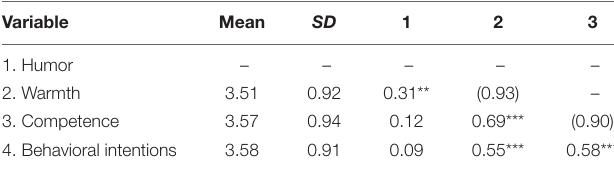
TABLE 1 | Descriptive statistics and